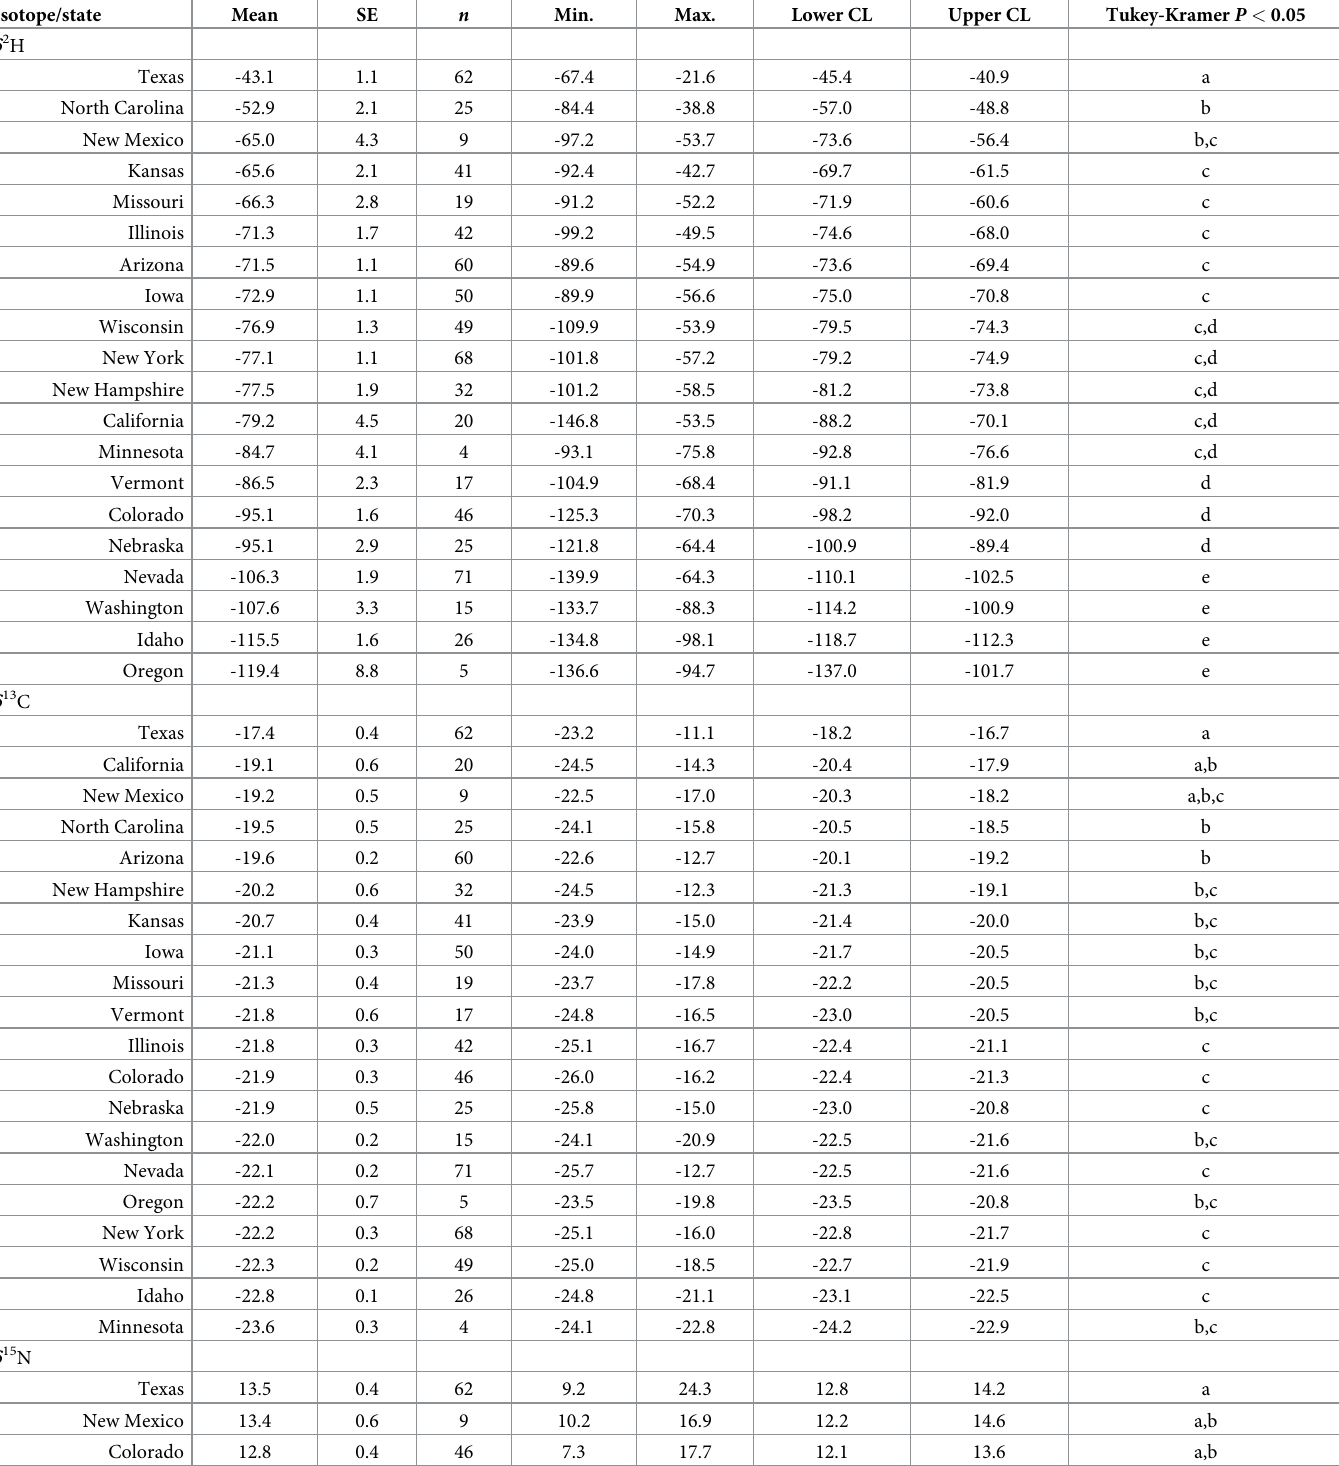
Table 1. Interstate comparisons of feather isotopes in all European starlings ( N = 686) collected at U.S. dairies and feedlots. For each of δ 2 H, δ 13 C and δ 15 N, statisti- cally different means between collection states are indicated by unique letters in the right column. Isotope/state